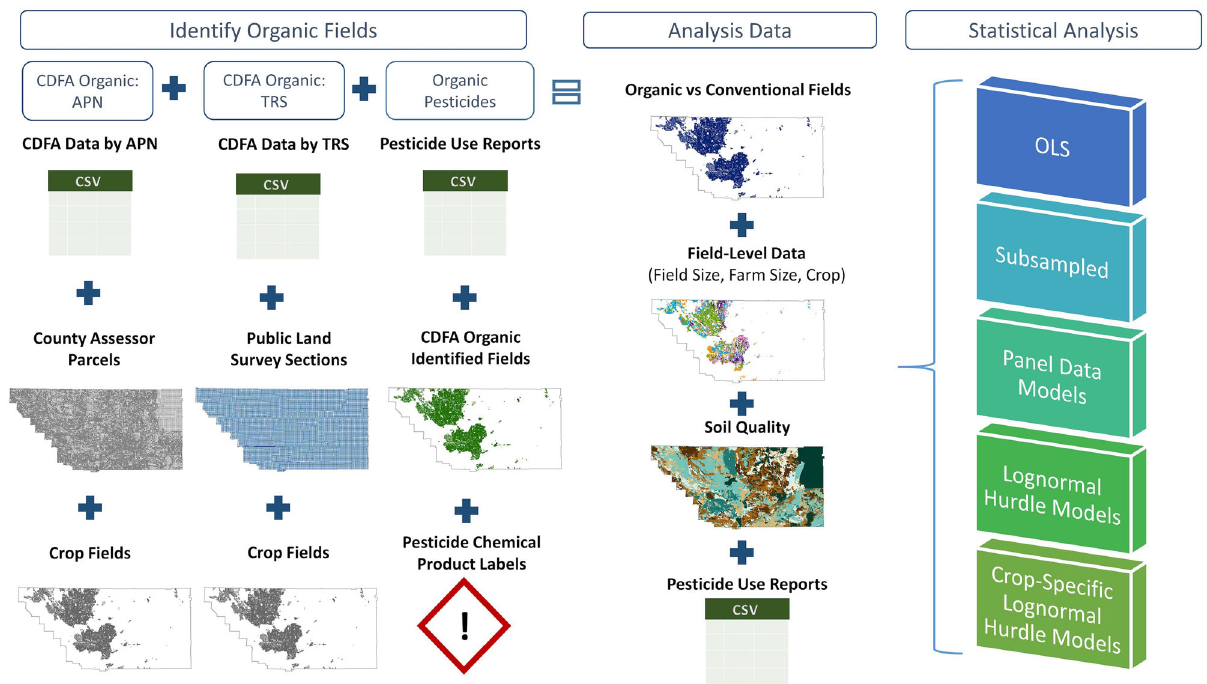
Fig. 5 Methodology overview. Figure outlines the main method steps from identifying organic fi elds to creating the analysis data to performing the statistical analyses. All images shown are simpli fi ed, visual representations of the datasets. CDFA refers to the California Department of Food and Agriculture, while APN is the Assessor ’ s Parcel Number and TRS is the Township-Range-Section. Identifying organic fi elds combines the created CDFA organic APN, CDFA organic TRS, and organic pesticides data layers together to create the fi nal organic versus conventional fi elds layer used in the analysis data section. All analysis data layers are then inputted into the various statistical